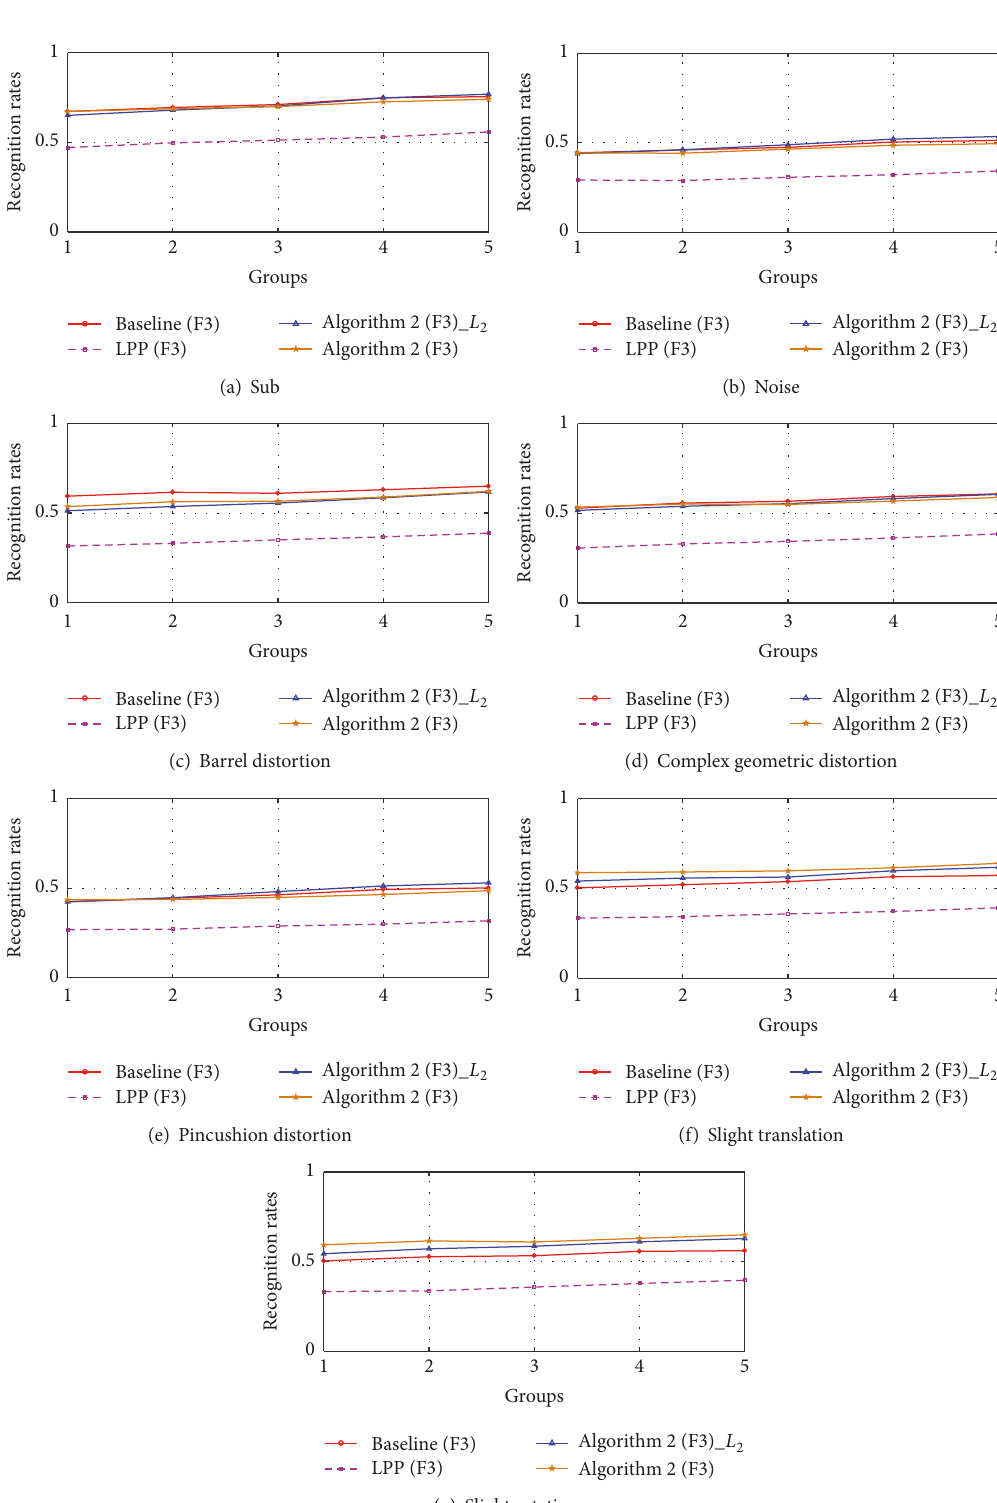
Figure 14: The recognition rates on noise, geometric distortion, slight translation, and slight rotation Extended Yale B face databases over “F3”